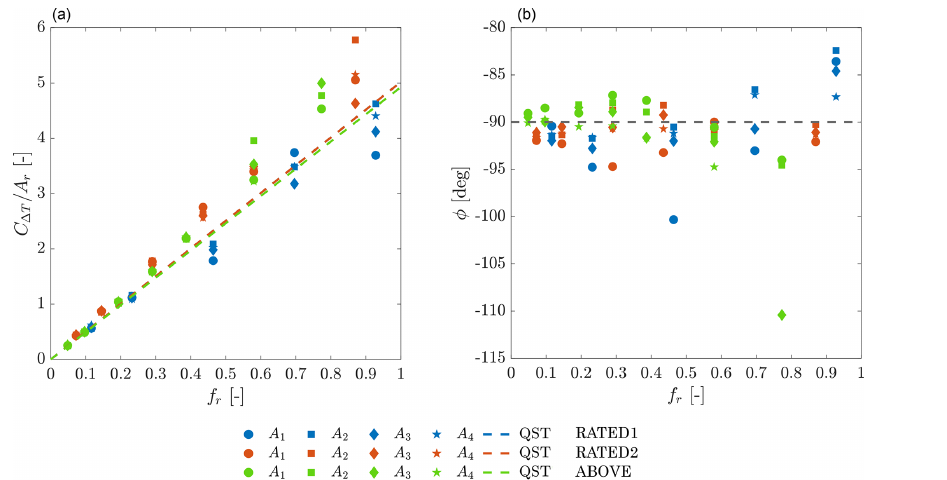
Figure 8. Unsteady thrust coefficient (a) and phase of the thrust force with respect to surge motion (b) against reduced frequency. Color is for mean wind speed, the markers are for surge amplitude (e.g., for RATED1 and f r = 0 . 928, • : 0.008m, (cid:7) : 0.015m, (cid:4) : 0.025m, and : 0.030m; see Tables B1–B3), and the dashed line for quasi-steady theory prediction.